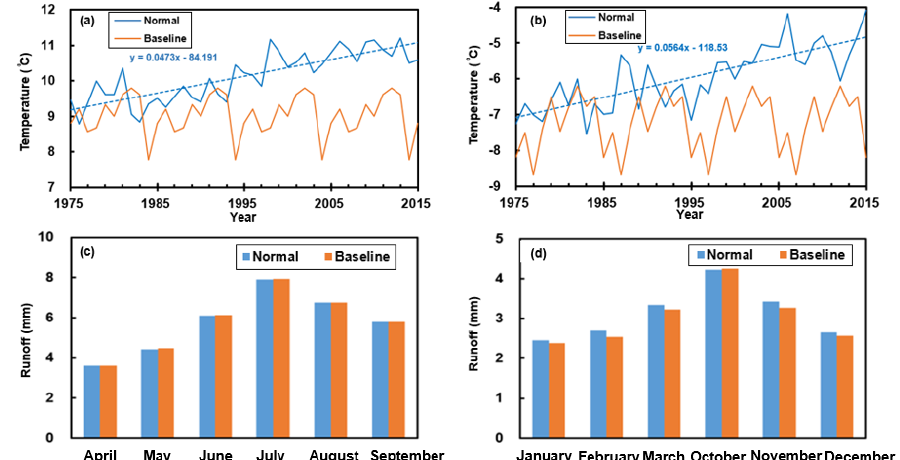
Figure 11. The trend of air temperature’s change in warm season ( a ) and cold season ( b ); The comparison of runoff with normal simulation and baseline simulation in warm season ( c ) and cold season ( d ).